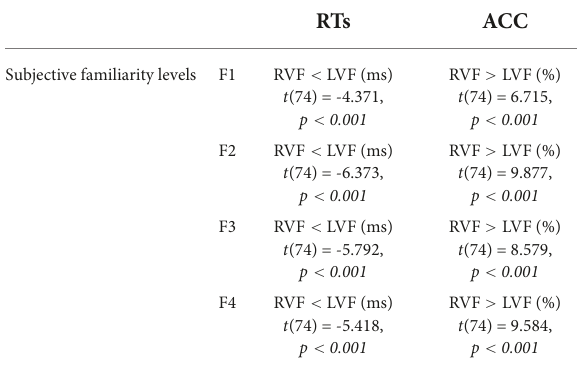
FIGURE3 Accuracy of words presented in the RVF, LVF, and BVF in four subjective familiarity levels. The four subjective familiarity levels indicate F1 ( M = 4.21, SD = 0.74), F2 ( M = 4.61, SD = 0.91), F3 ( M = 5.10, SD = 0.75), and F4 ( M = 5.46, SD = 0.78). The line in the bar graph denotes the range of standard error.